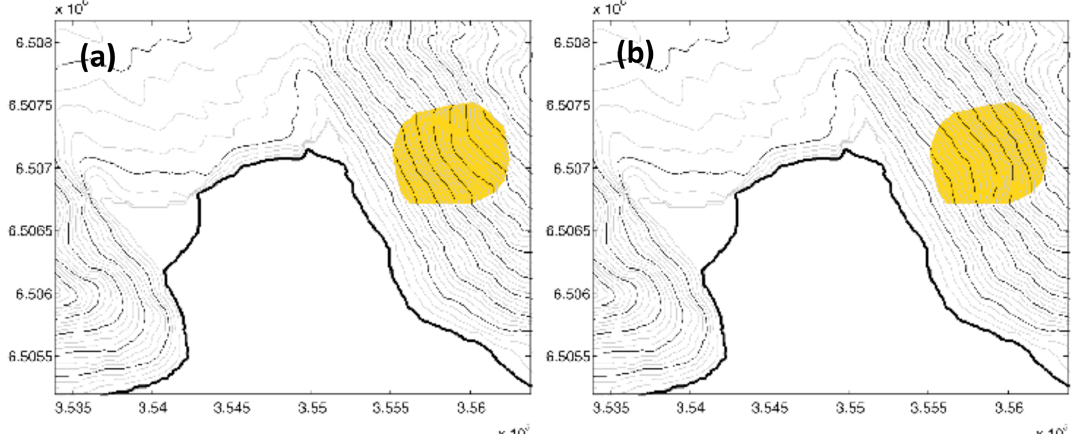
Figure 4. Details about the reconstructed slide. The isolines into the yellow area have been modified to reconstruct the location of the slide previous to the event. (a) Reconstructed topography of the east spur of Gilbert Inlet (before). (b) Topography of the east spur of Gilbert Inlet after the